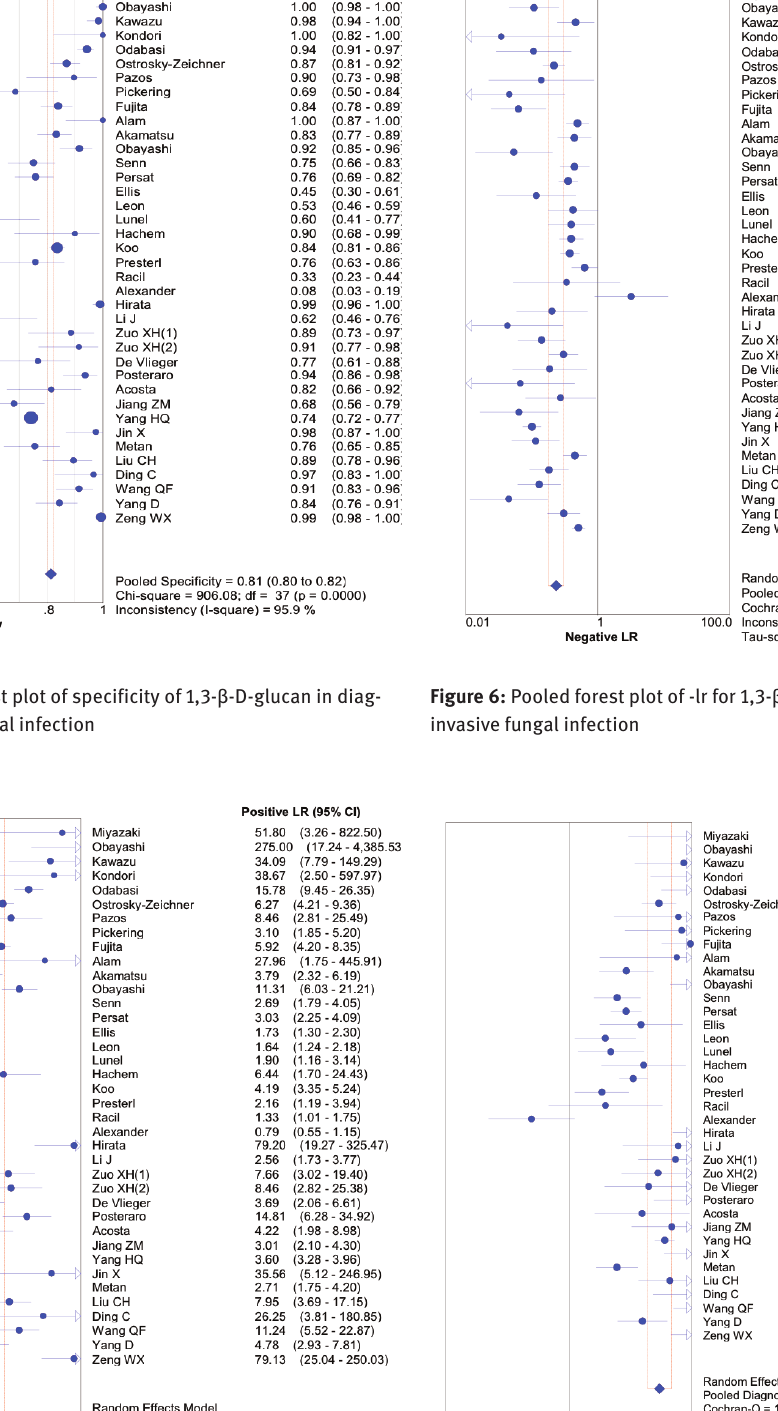
Figure 5: Pooled forest plot of +lr for 1,3-β-D-glucan in diagnosis of invasive fungal